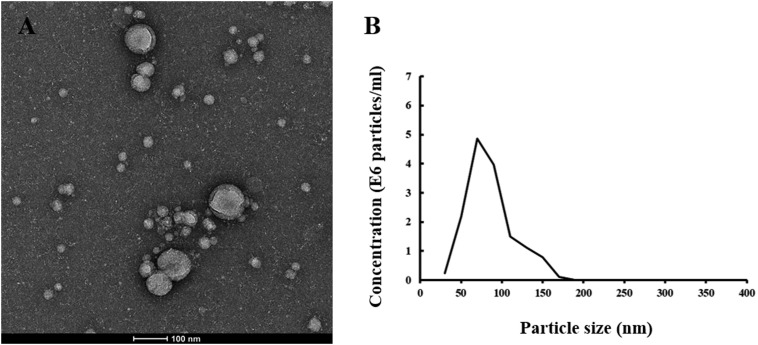
Plasma neuronal-derived exosomes identified with TEM and NTA. (A) A representative image detected with transmission electron microscopy of exosomes extracted from an AD patient. The scale bar equals 100 nm. (B) A representative plot of size/concentration determined with nanoparticle tracking analysis for plasma exosomes derived from an AD patient.